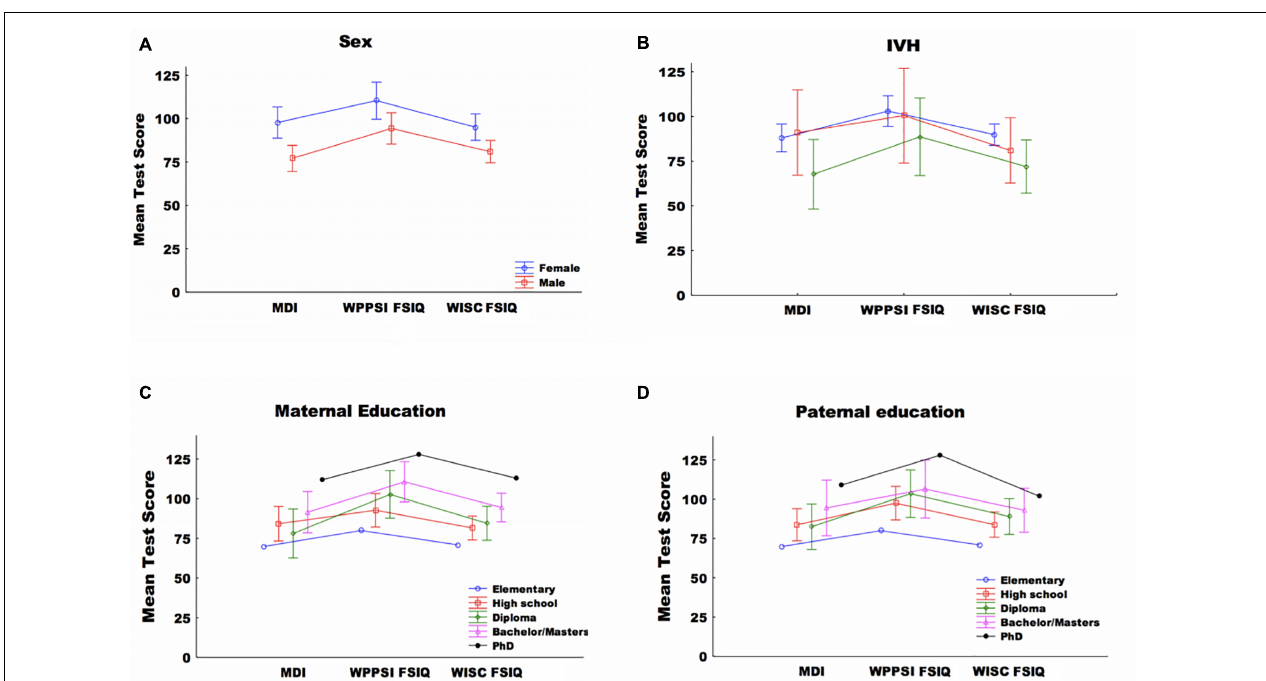
FIGURE 2 | (A) Mean test score by sex and test type. (B) Mean test score by IVH and test type. (C) Mean test score by maternal educational level and test type, (D) mean test score by paternal educational level and test type. Mental development index (MDI), WPPSI-III Full scale index (FSIQ), and WISC-IV Full scale index (FSIQ) 18 month, 5 and 11 years, respectively. Data is presented as mean + SEM.